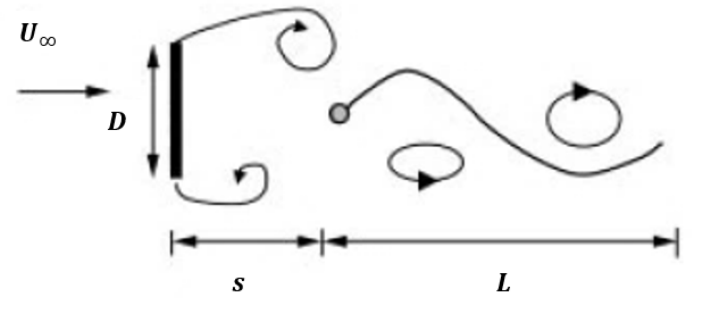
Figure 3. Geometry of oscillating membrane behind flat plate